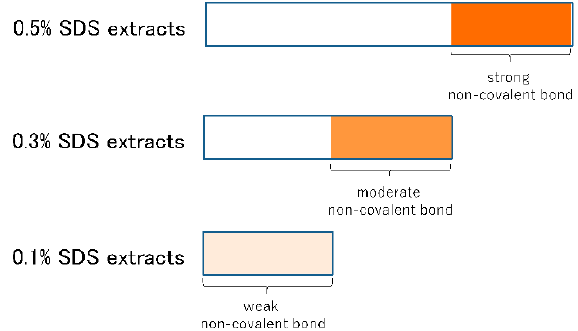
Figure 7. A descriptive sketch of the amount of protein aggregated through various strengths of non-covalent bonds. The amount of protein aggregated through strong non-covalent bond = “the average amount ( n = 6) of protein aggregates extracted with 0.5% SDS buffer” − “the average amount ( n = 6) of protein aggregates extracted with 0.3% SDS buffer”, moderate non-covalent bond = “the average amount ( n = 6) of protein aggregates extracted with 0.3% SDS buffer” – “the average amount ( n = 6) of protein aggregates extracted with 0.1% SDS buffer”, weak non-covalent bond = “the average amount ( n = 6) of protein aggregates extracted with 0.1% SDS buffer”.